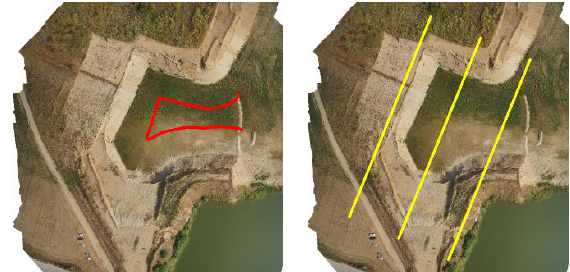
Figure 5. Flight plans for Block 5 (left) and Block